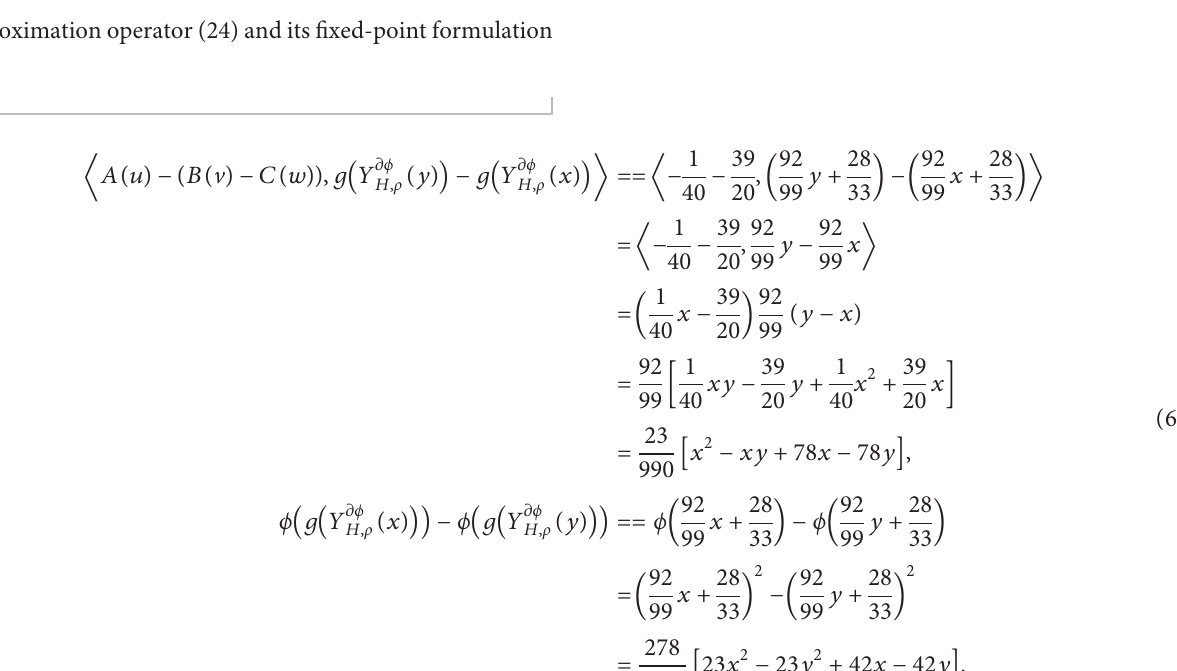
Table 1: Computational results for different initial values x